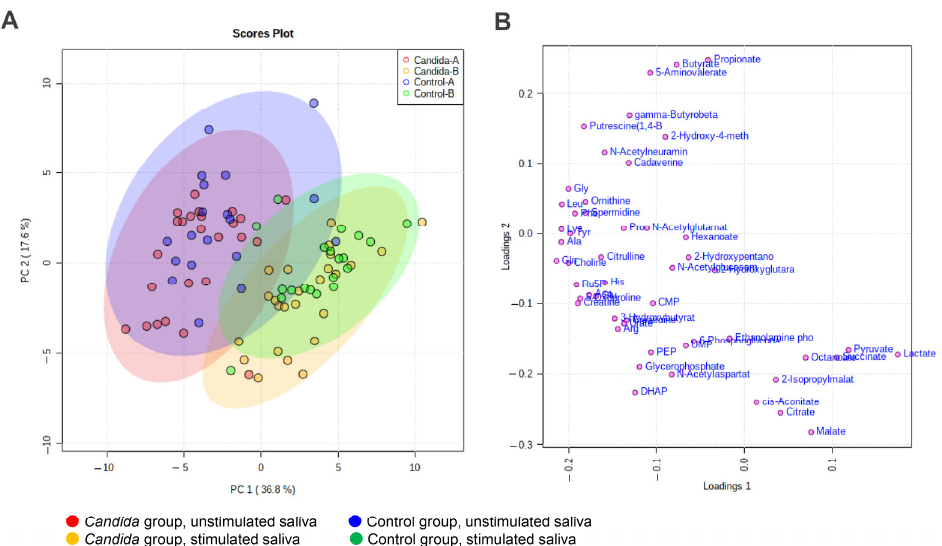
Figure 2. Prinicipal Component Analysis (PCA) of metabolites detected in participants’ unstimulated and stimulated saliva. PCA of the detected salivary metabolites was performed. Score plot and loading plot of the PCA with the 51 metabolites were used for visualization. ( A ) Score plot of metabolites detected in participants’ unstimulated and stimulated saliva. X and Y-axes indicate the contribution ratios of PC1 and PC2, respectively. Each point on the score plot represents one saliva sample, and the shorter the distances between points the higher similarity of their salivary metabolite concentration patterns. ( B ) Loading plot of metabolites detected in participants’ saliva. In the loading plot, each point represents one metabolite. The used options to process the data were (1) sample normalization: normalization by sum, (2) data transformation: Log transformation, and (3) data scaling: Auto scaling.